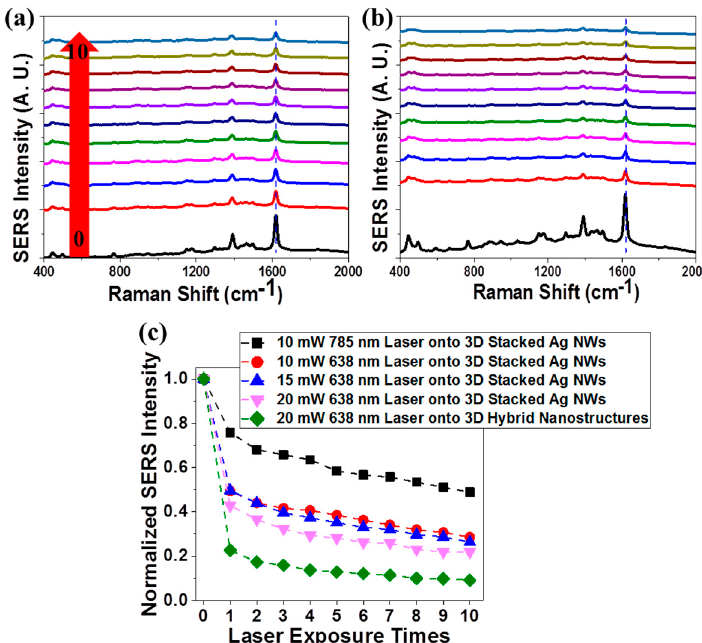
Figure 8. SERS intensity changes in the MB deposited onto ( a ) 3D stacked Ag NWs structures and ( b ) 3D hybrid (0.002 wt% TiO 2 /Ag NWs) nanostructures during 638 nm laser exposure (10 s). The SERS measurements were performed by illuminating with a 638 nm laser for only 0.01 s to avoid photocatalytic effects. ( c ) The overall SERS intensity changes at 1620 cm − 1 in MB molecules under different illumination